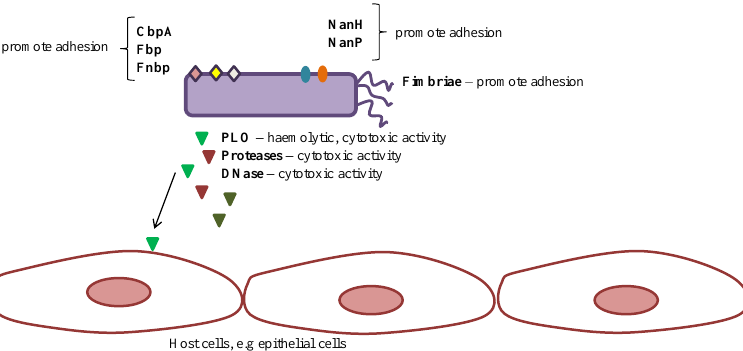
Figure 2. Schematic diagram of known virulence factors of T. pyogenes